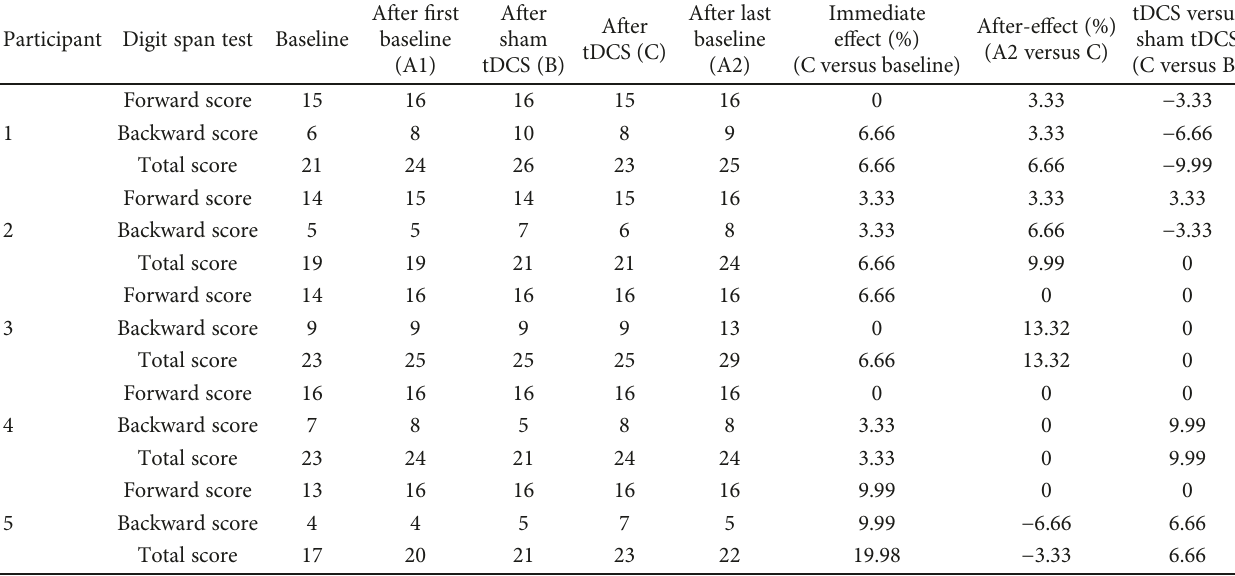
Table 3: Digit span test score.